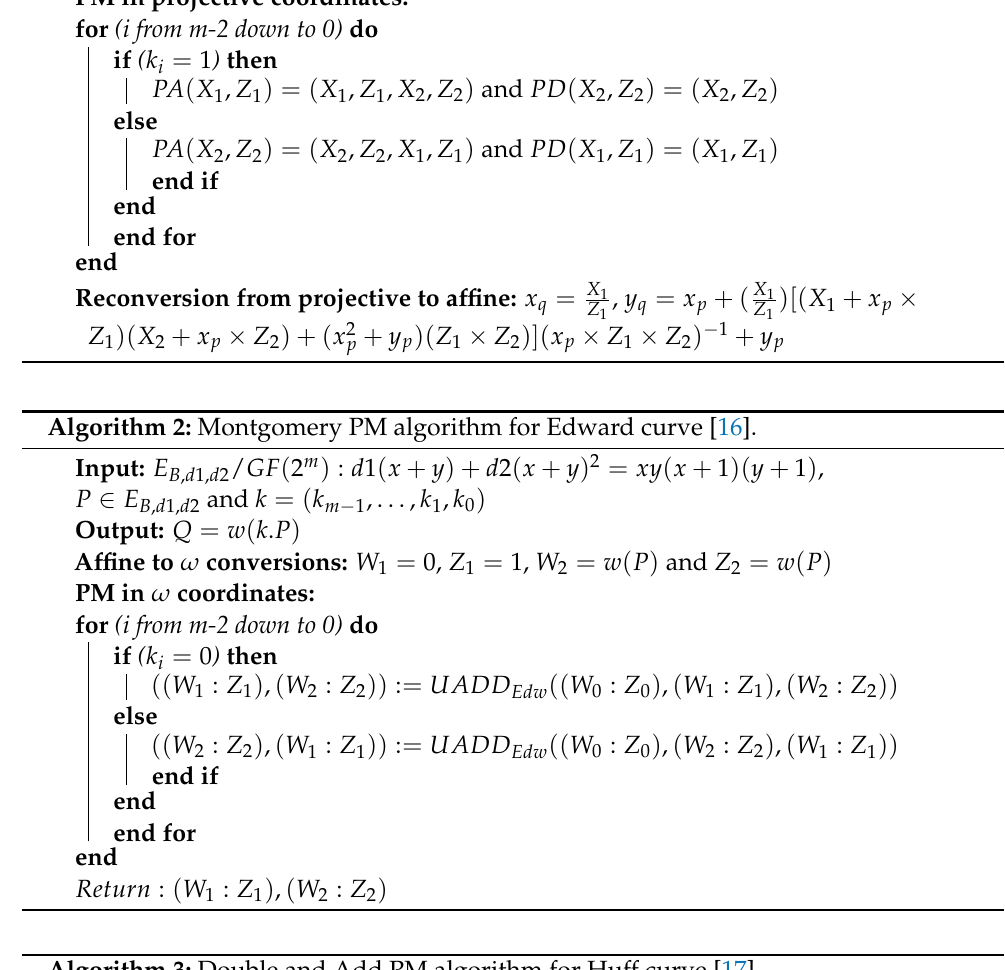
Algorithm 3: Double and Add PM algorithm for Huff curve